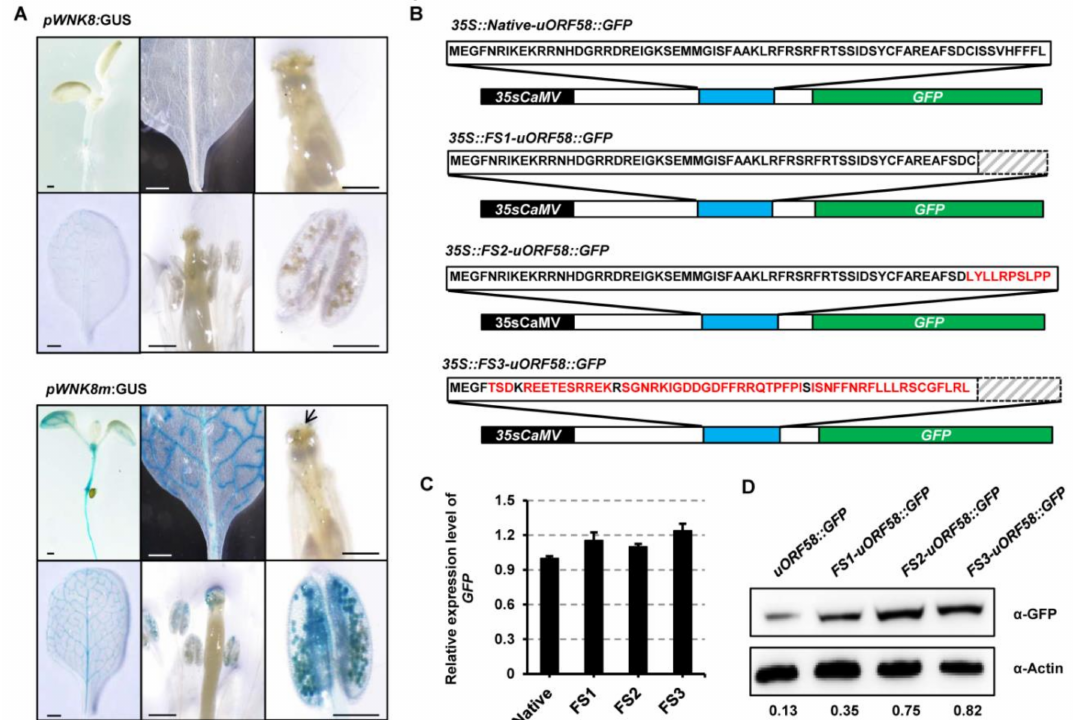
Figure 3. Mutated CPuORF58 enhance the translation of different downstream mORFs. ( A ) GUS expression analyzed by histochemical detection in different stages of seedlings or plants transformed with native promoter pWNK8:GUS or site-mutated promoter pWNK8m:GUS . ( B ) Schematic representation of the constructs for Arabidopsis transformation. The amino acid sequences of the native and mutated uORF with different ones in red were shown at the bottom. FS is short for frame shift; the black box represented 35S CaMV promoter; the white boxes are for WNK8 5 (cid:48) -UTR; the light blue boxes are shown as CPuORF58; the green boxes are for GFP ORFs. The expression levels of GFP were analyzed using qRT-PCR ( C ) and immunoblotting ( D ) of plants transformed with indicated genetic constructs. Actin2 was used as the internal